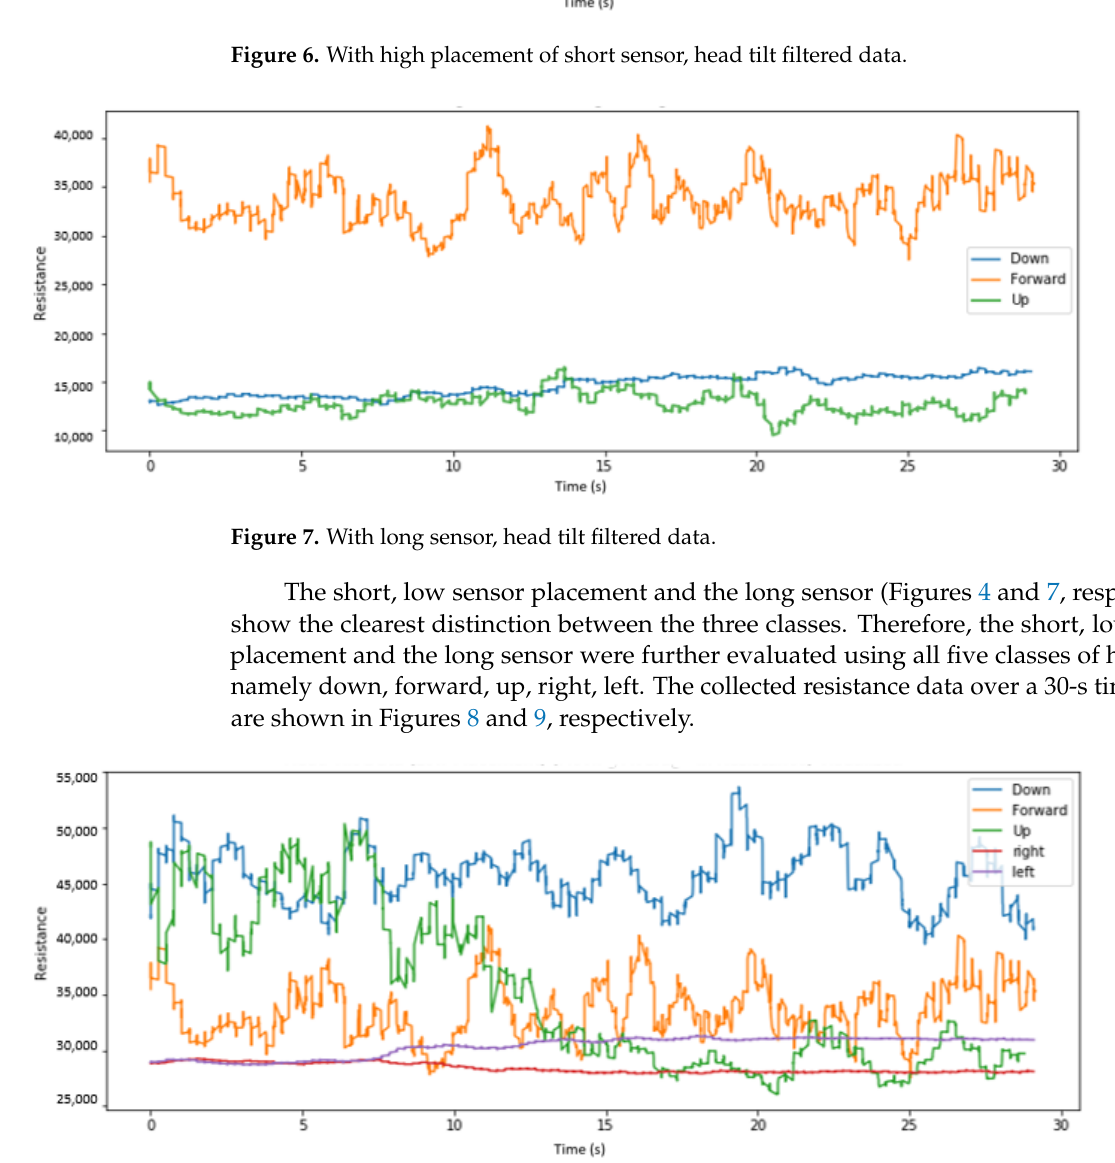
Figure 9. With long sensor, head tilt filtered data, with right and left tilts added. 4.3. Head Tilt Detection Machine Learning Results We evaluated the accuracy of classifying a three-class dictionary of head tilts. We then went on to evaluate the accuracy of classifying an expanded five-class dictionary of head tilts. The classification results are presented in this subsection. Three different classical machine learning (ML) classifiers were considered, specifi- cally logistic regression, SVM, and random forest. The labeled dataset was partitioned into a train and held-out test set with an 80:20 ratio. To ensure the consistency of the models, a k -fold cross-validation was performed. A fivefold cross-validation of the train set was performed, with a random fourth of the examples in the training fold being used for val- idation during hyper-parameter tuning. For all the classical ML models, the Scikit-learn library in Python was used. All four configurations, i.e., the long sensor and the three (low, center, and high) placements of the short sensor, were evaluated using the three head tilts (down, for- ward/not tilt, and up). Table 1 displays our fivefold accuracy based on the model and placements of the sensors. In all cases, Logistic Regression was not sufficient in classifying the three-class dictionary. The short and low sensor placement and the long sensor had the best results. In both cases, random forest is the best performing model with test accuracies reaching ~83.4% and ~96% for the short, low placement and the long sensor, respectively.